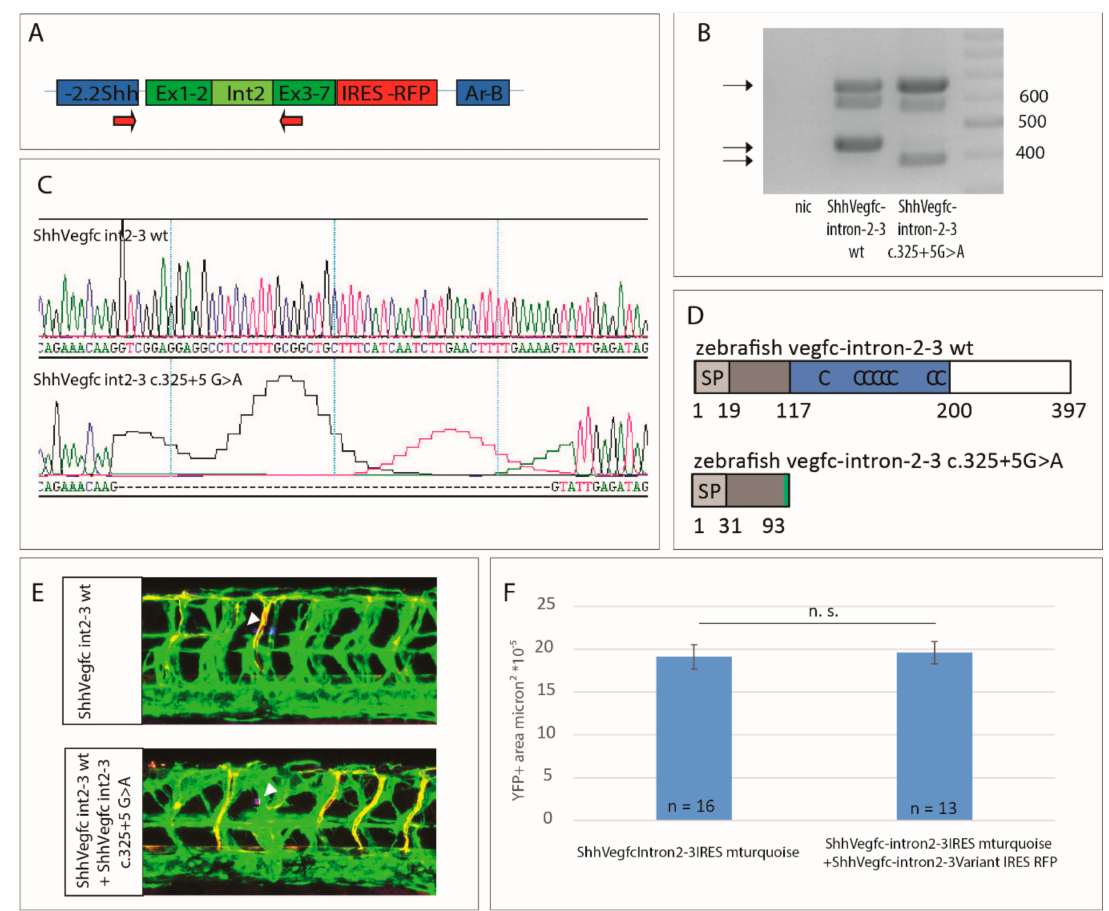
Figure 4. The vegfc c.325+5G>A splice-site variant results in a truncated protein, which does not have dominant negative activity. ( A ) Diagram of the construct used for overexpression of vegfc-intron 2–3 depicting primers used for RT-PCR (arrows). ( B ) RT-PCR of zebrafish embryos expressing ShhVegfc-intron 2–3 wt or ShhVegfc-intron 2–3 c.325+5G>A. Embryos expressing the wt form of ShhVegfc-intron 2–3 and the ShhVegfc-intron 2–3 c.325+5G>A variant express a band of 660 bp corresponding to non-spliced RNA or integrated plasmid DNA as well as a second smaller band corresponding to wt ShhVegfc (440 bp) or mutant ShhVegfc (387 bp). Right lane: 100 bp ladder. Non-injected control, nic. ( C ) Sequencing of cDNA of embryos expressing ShhVegfc-intron 2–3 and the ShhVegfc-intron 2–3 c.325+5G>A variant showing a 53 bp deletion in the ShhVegfc-intron 2–3 c.325+5G>A variant (lower panel). ( D ) Schematic representation of predicted wild type (top) and mutant (bottom) proteins. Mutant protein consists of the first 91 amino acids of Vegfc containing only a part of the N-terminus of Vegfc but not the VHD or the C-terminus (see Figure 2 for legend). ( E ) Analysis of co-overexpression of ShhVegfc-intron 2–3 wt and ShhVegfc-intron2–3 c.325+5G>A in the floorplate using the transgenic line Tg(flt4 BAC :mCitrine) hu7135 and Tg(flt1 enh :tdTomato) , which marks venous and lymphatic cells in green and arterial vessels in red at 48 hpf. Expression of ShhVegfc-intron 2–3 wt and ShhVegfc-intron 2–3 c.325+5G>A within the same cell are monitored by the simultaneous expression of mturquoise and tagRFP, respectively. Forced expression of ShhVegfc-intron 2–3 wt in the floorplate led to excessive vessel sprouting comparable with co-overexpression of ShhVegfc-intron 2–3 wt and ShhVegfc-intron 2–3 c.325+5G>A in the floorplate. Arrow heads mark expression of tagRFP and mturquoise in the floorplate. ( F ) Quantification of lymphovenous sprouting by measuring the YFP positive area surrounding the site of mturquoise/tagRFP expression. Values are presented as means ± standard error of mean values (SEM). n.s. not